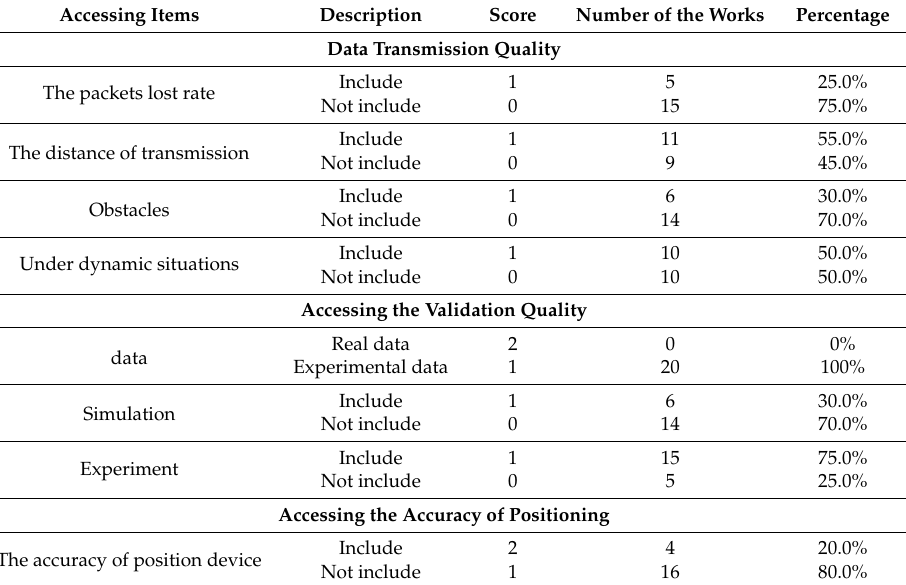
Table 5. Distribution of quality characteristics across review